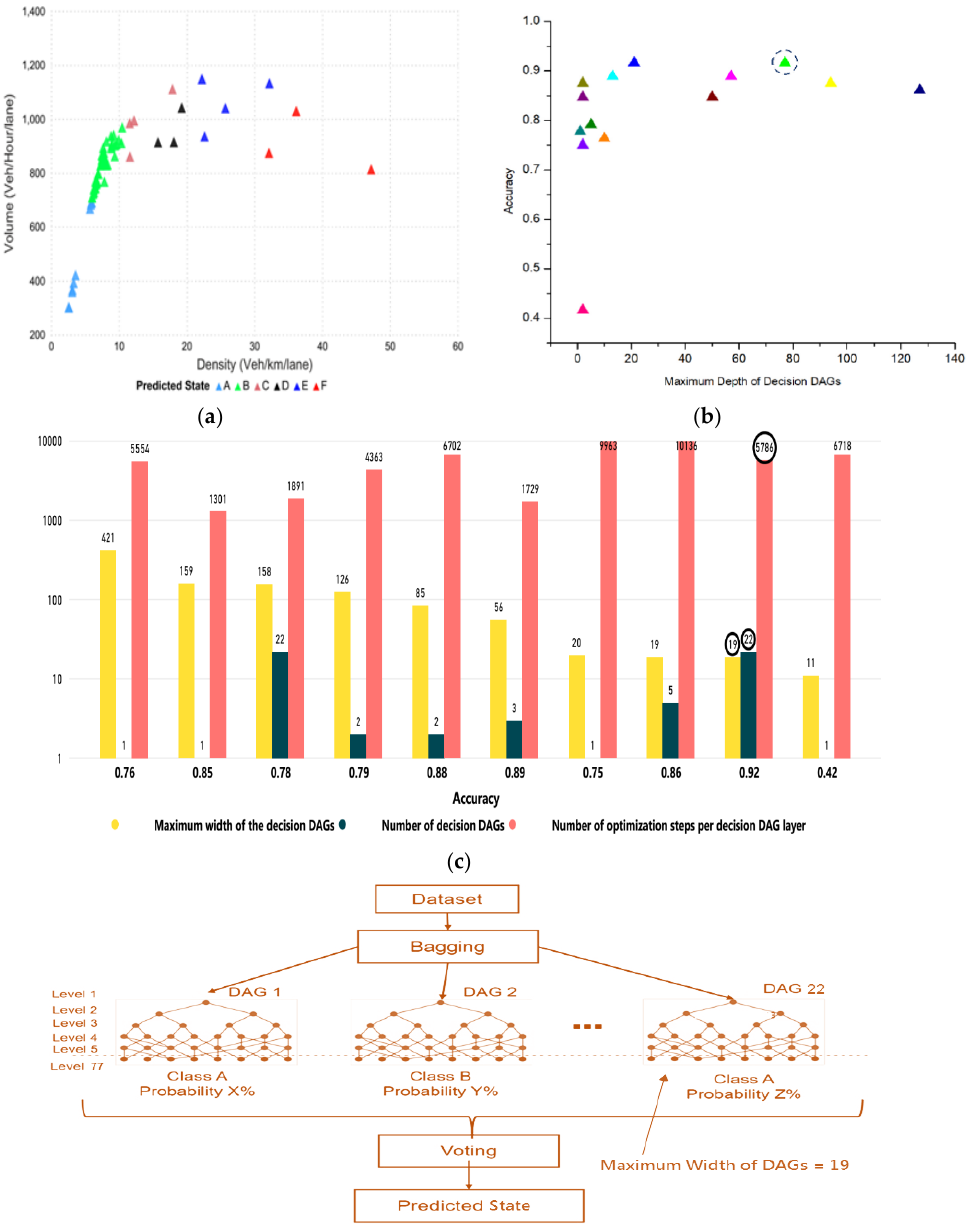
Figure 9. Decision jungle model. ( a ) The impact of maximum depth on accuracy. ( b ) Predicted state for the next 15 min. ( c ) Impact of maximum width of the decision DAGs and number of decision DAGs on accuracy. ( d ) Number of DAGs, width, and depth of DAGs are shown for 15-min prediction horizons.